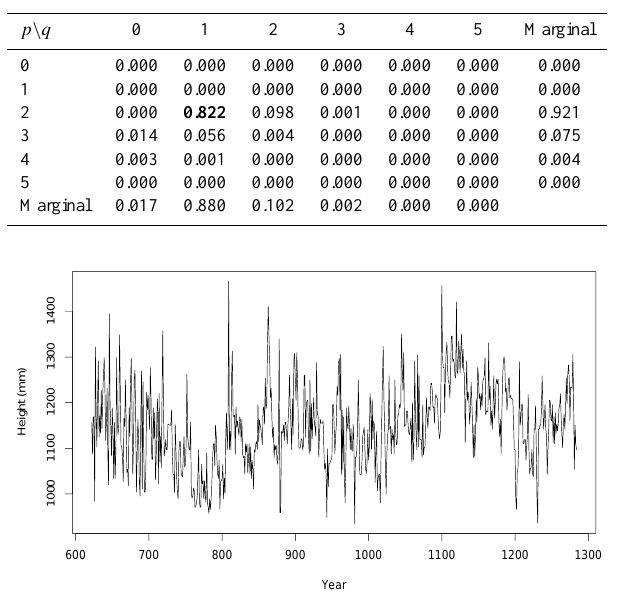
Table 3. Posterior model probabilities based on simulations of model Eq. (10) for the autoregressive parameter p and moving av- erage parameter q . Bold numbers denote the true model.